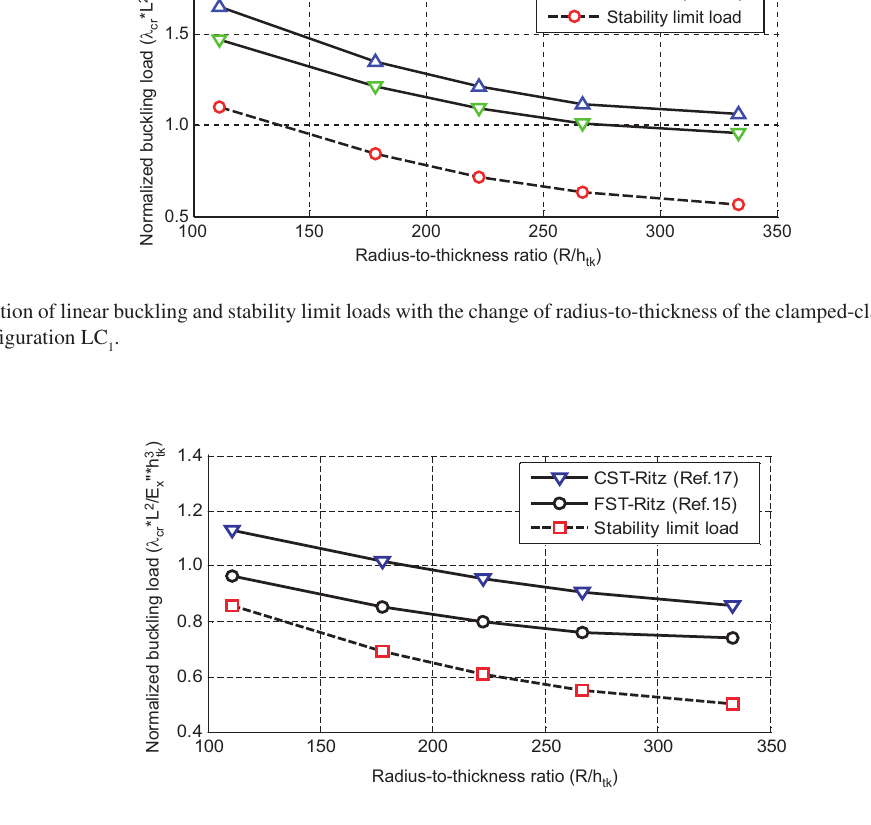
Figure 7 Variation of linear buckling and stability limit loads with the change of radius-to-thickness of the clamped-clamped hybrid laminate . with lay-up confi guration LC 2